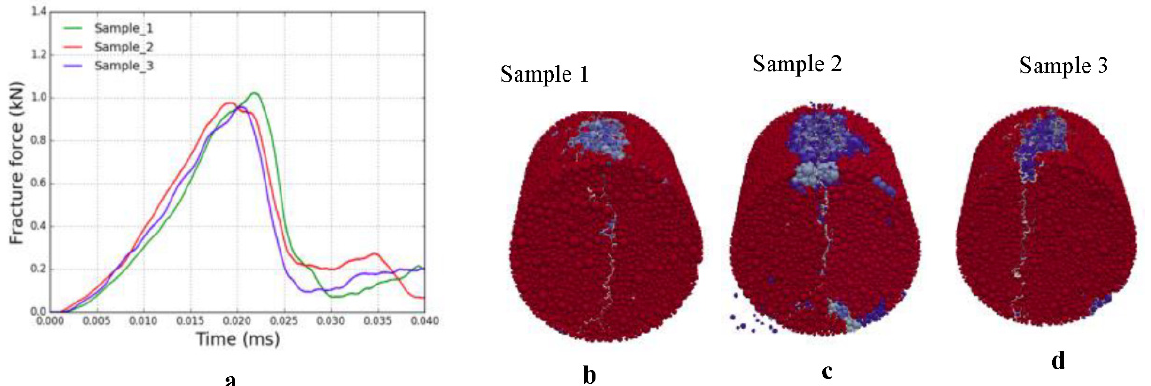
Figure 10. ( a ) Force-time histories of three rock specimens at 30-crack level and ( b – d ) their respective post-process analyses showing the fracture pattern.